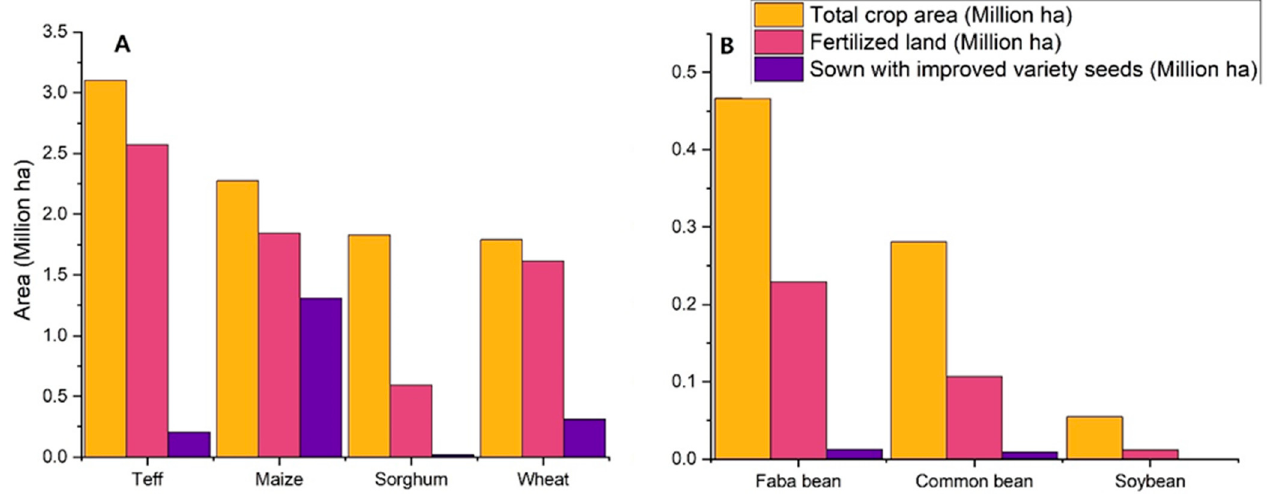
Figure 3. Application of fertilizer and improved variety seeds in selected cereals ( A ) and grain legumes ( B ).